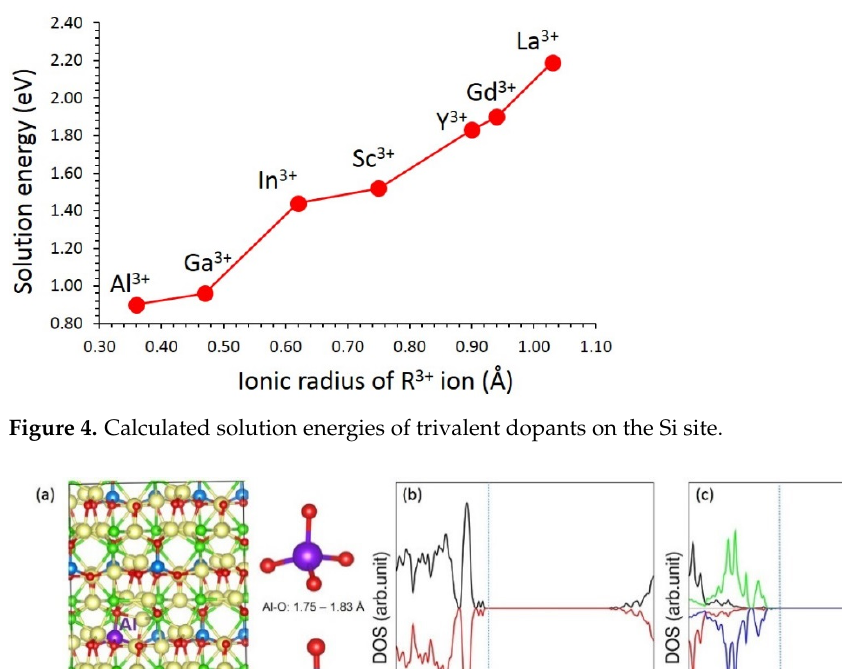
Figure 4. Calculated solution energies of trivalent dopants on the Si site.